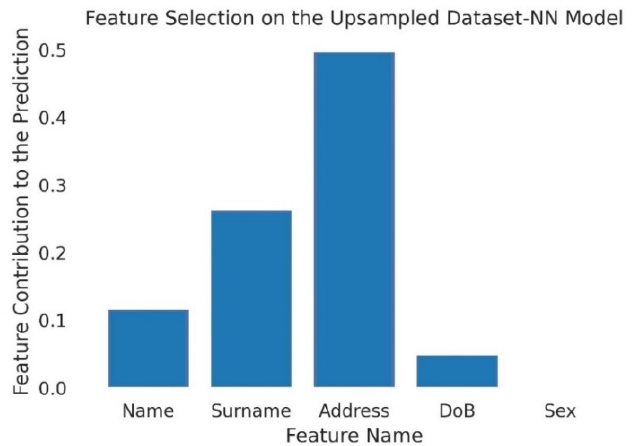
Figure 8. Feature importance of the NN model using the up-sampled dataset as input.